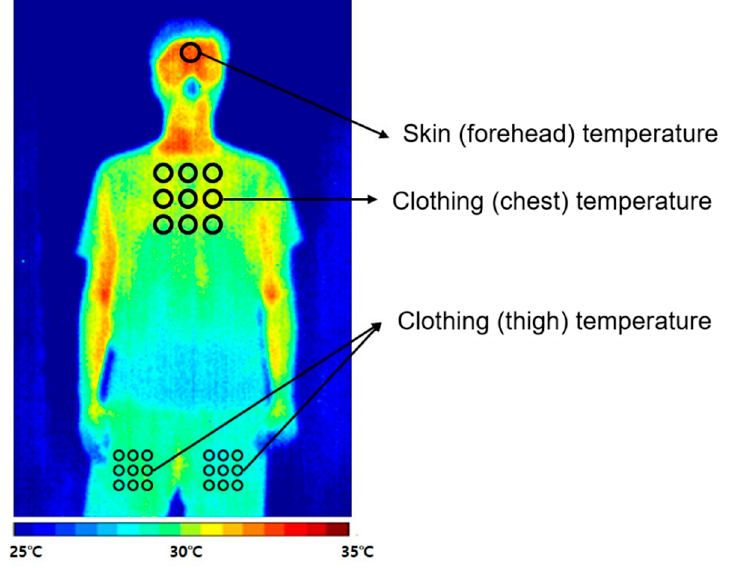
Figure 7. Skin and clothing temperatures used in the prediction models.